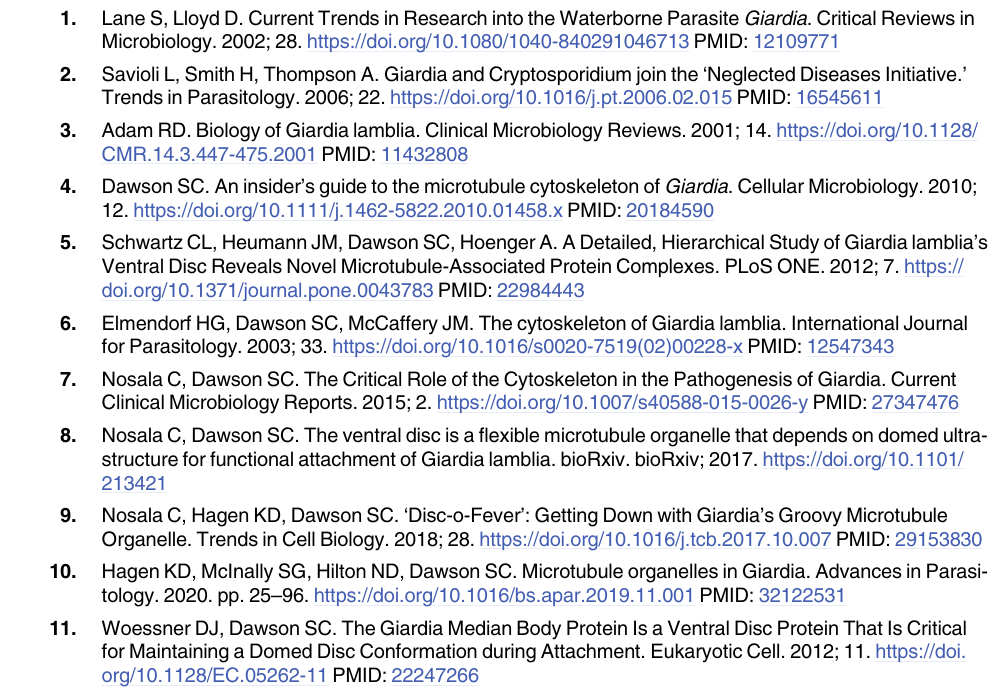
S4 Table. Number of microspheres per cell and